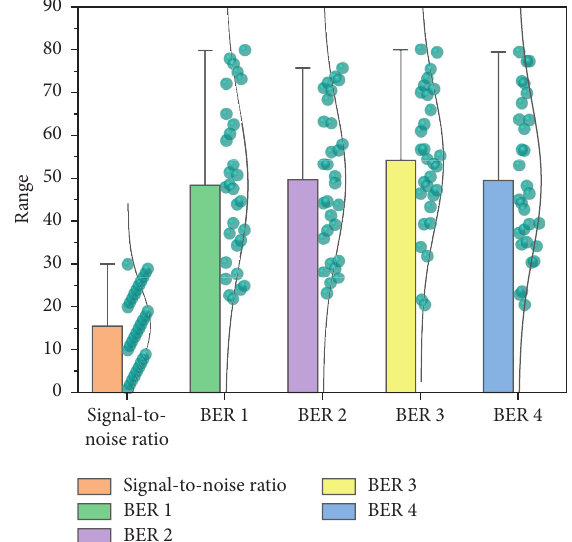
Figure 9: Simulation results of the high-speed hydroacoustic OFDM communication system based on Turbo codes-signal-to- noise